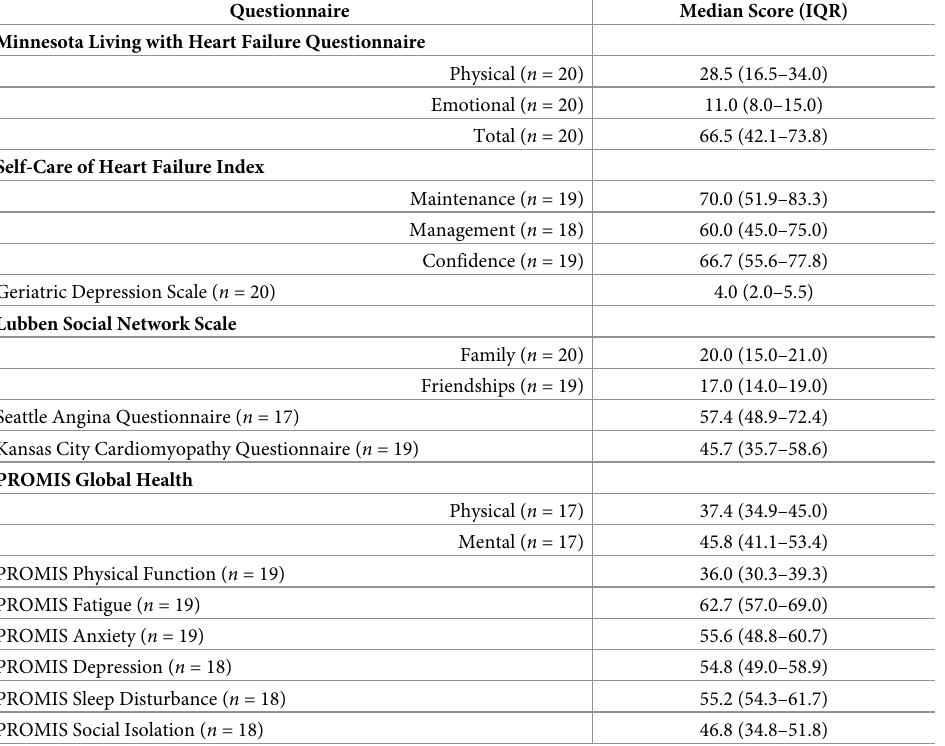
Table 4. Questionnaire scores at